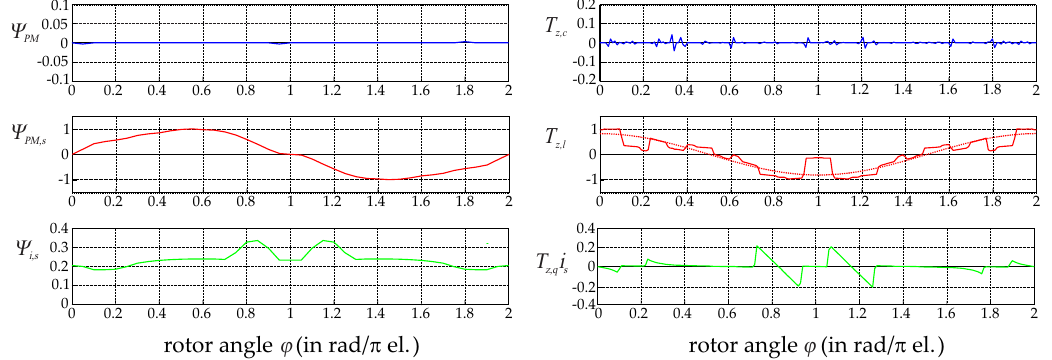
Figure 6. Analytically computed flux linkages ( left ) and separated torque components ( right ); all curves were normalized with the maximum of Ψ PM,s and T z,l